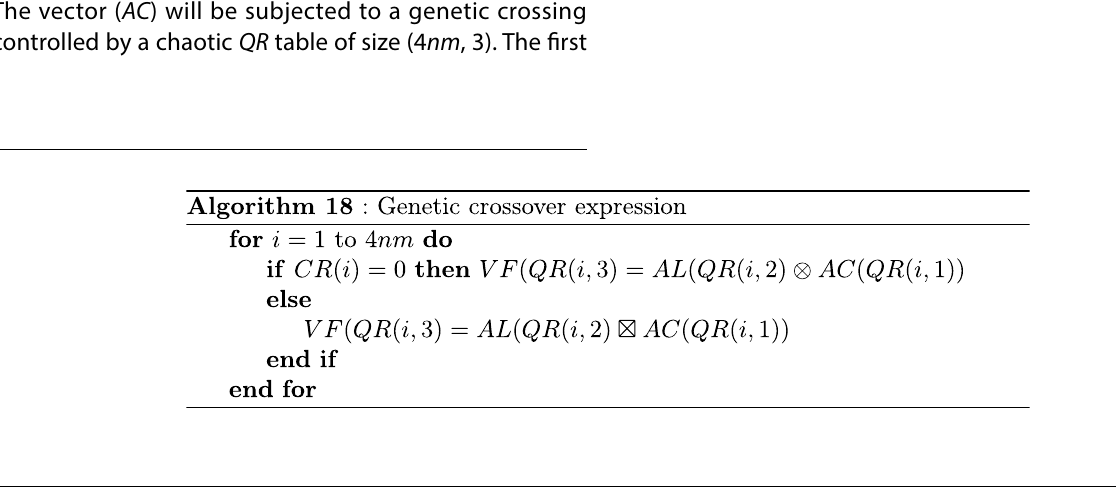
Figure 7 can be interpreted by the following